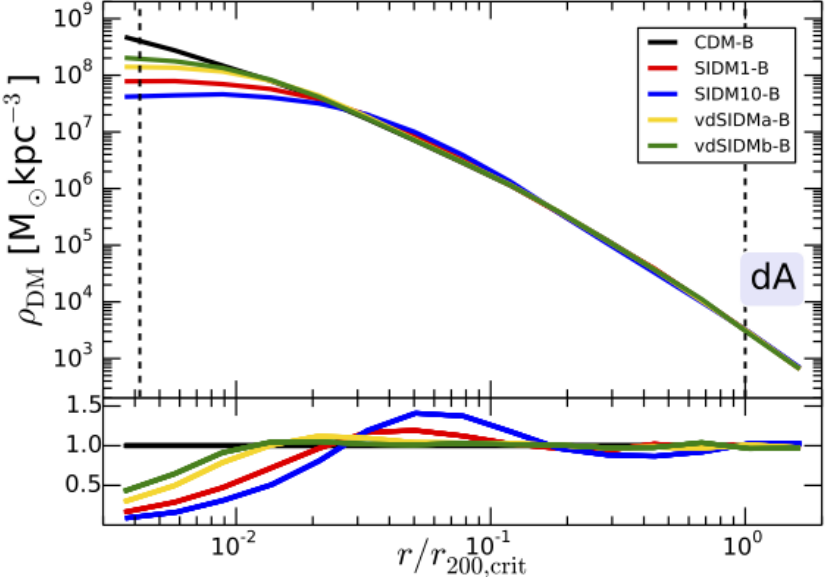
Figure 3. DM halo profile for collisionless standard Λ CDM (black) and for the self-interacting DM scenario (SIDM) with different cross-section (coloured), see